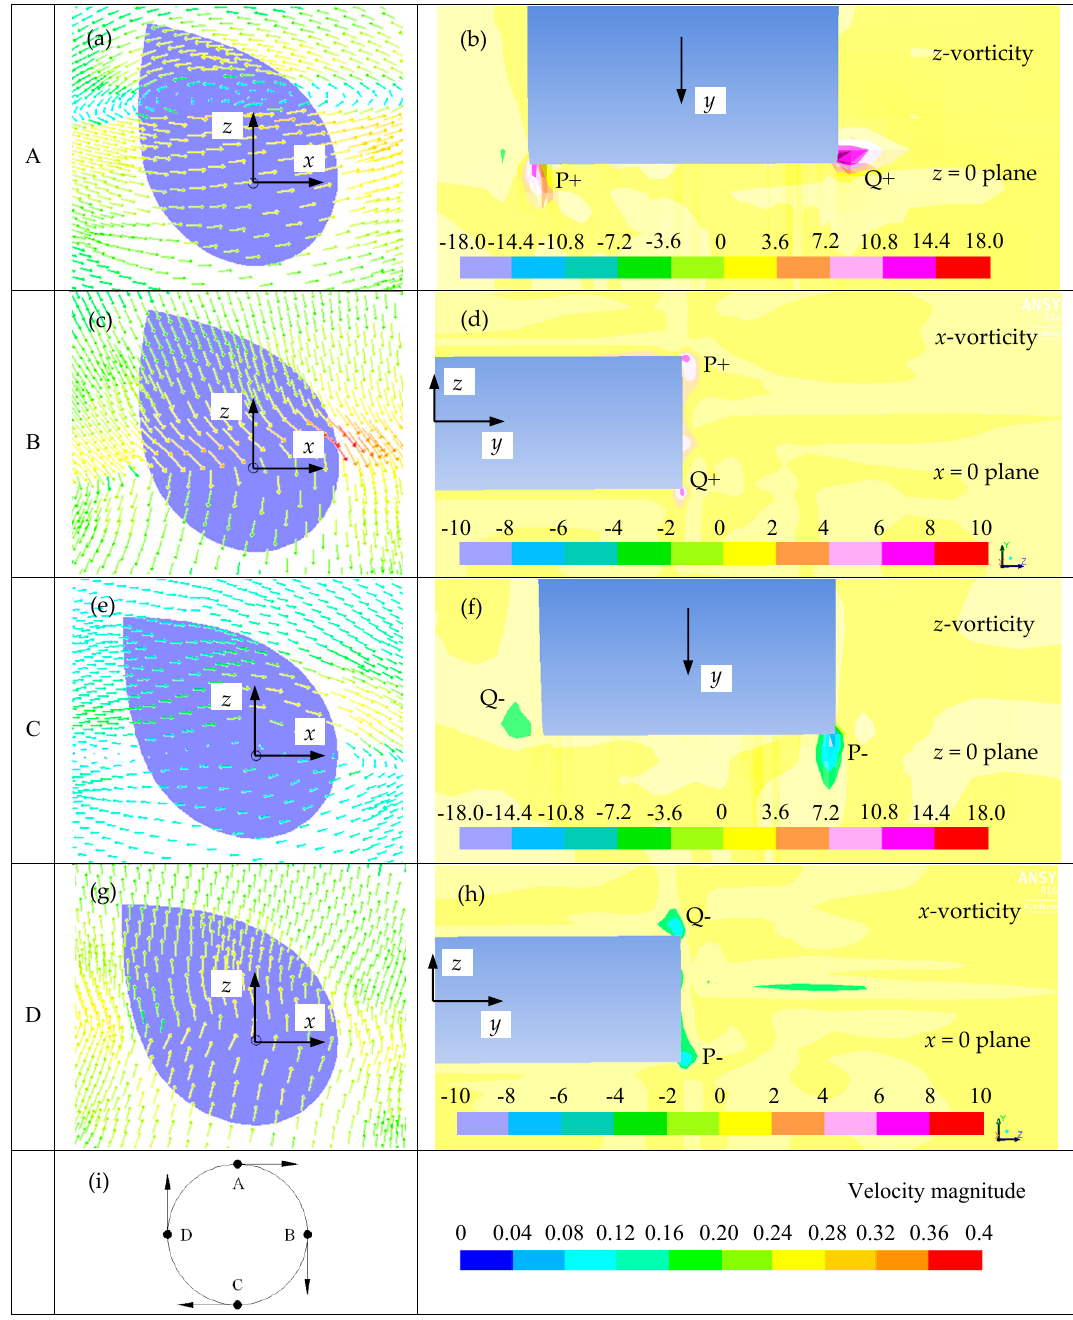
Figure 15. Fluid velocity and vorticity distribution at the end of the Duck at T = 1.6 s and H = 0.12 m. The subfigures in the left column show the approximately undisturbed fluid velocity vector distribution in the plane y = 2.4 m, with subfigures ( a , c , e , g ) for time instances A, B, C and D, respectively. The subfigures in the right column show the vorticity of the main vortex in either the free surface, i.e., z = 0 plane, or the perpendicular surface, i.e., x = 0 plane, with subfigures ( b , d , f , h ) for time instances A, B, C and D, respectively. Subfigure ( i ) shows the velocity direction of water particles at di ff erent time